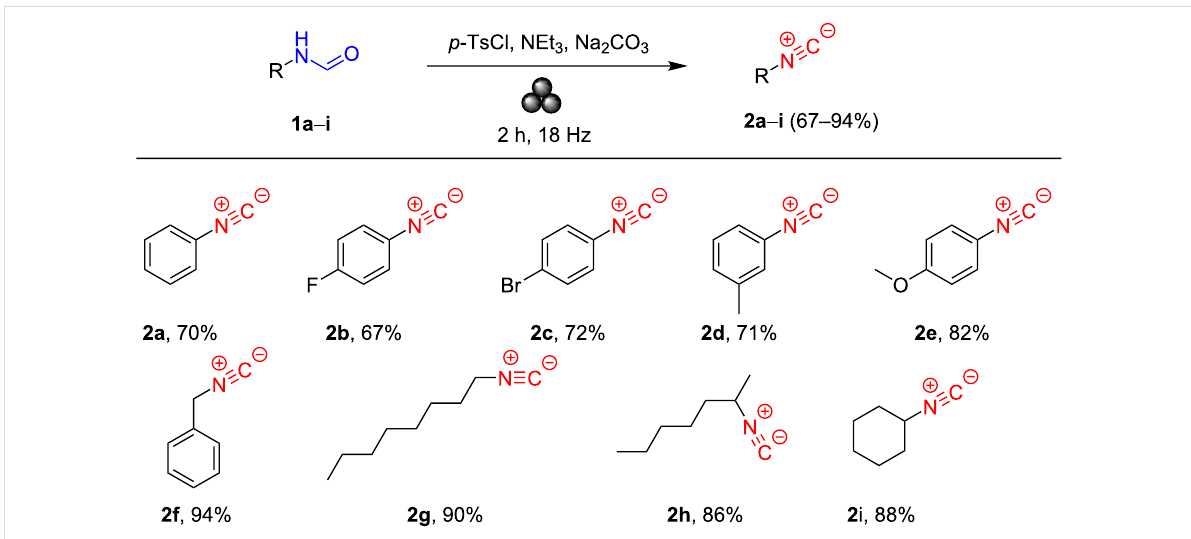
Scheme 3: The scope of our isocyanide synthesis using aliphatic and aromatic primary formamides. Reaction conditions: formamide 1a – i (1.0 mmol), p -TsCl (1.5 mmol), triethylamine (1.0 mmol), dry Na 2 CO 3 (6.0 mmol), 1 h, zirconia jar (15 mL), 2 balls (Ø = 8 mm), 18